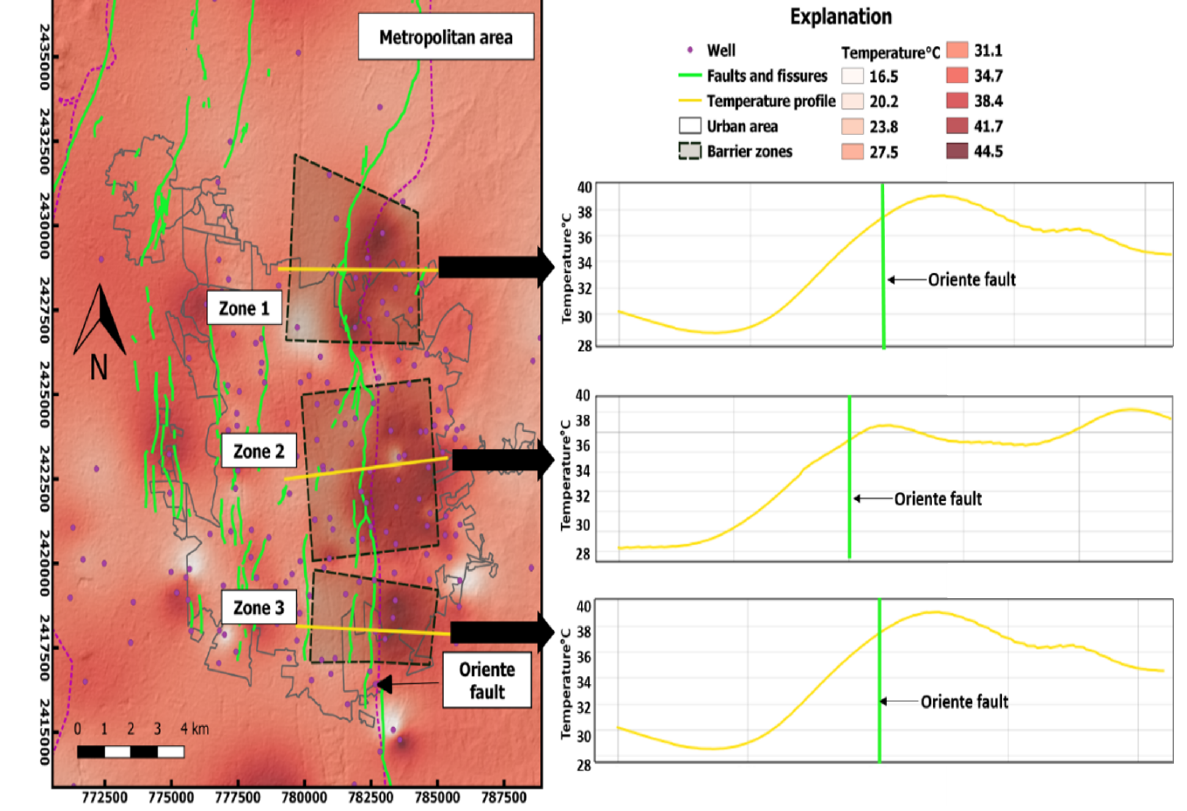
Figure 3. Comparison of geothermal anomalies and the Oriente fault.